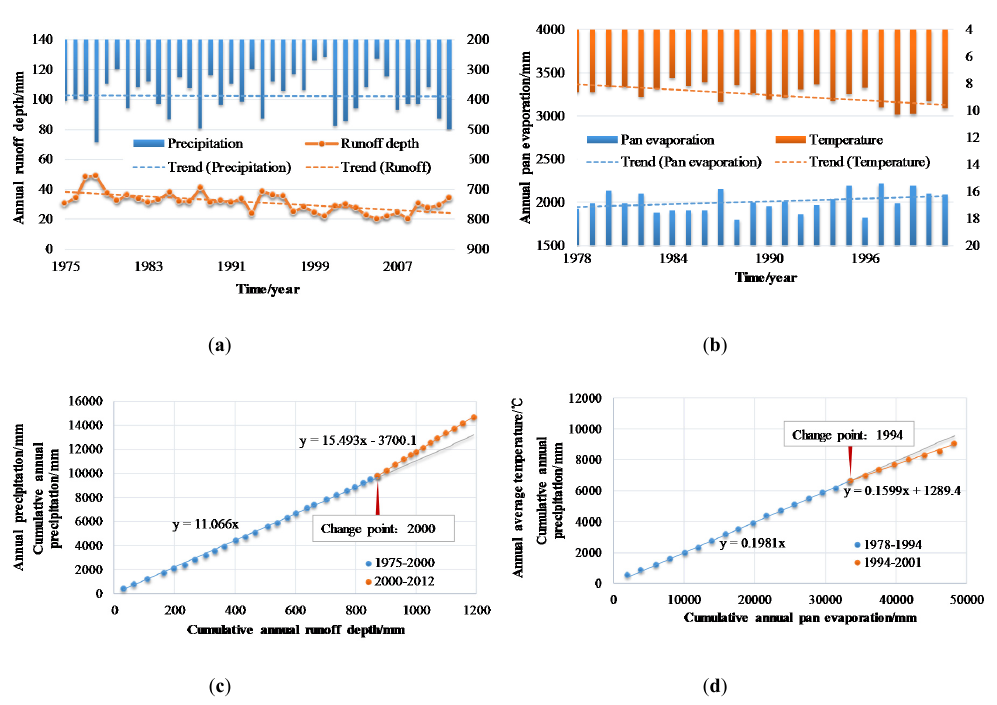
Figure 2. The variability of annual precipitation and runoff ( a ), pan evaporation and mean air temperature ( b ), double cumulative curves of annual precipitation and runoff depth ( c ), and annual precipitation and pan evaporation ( d ) in the Wuding River Basin (WRB).